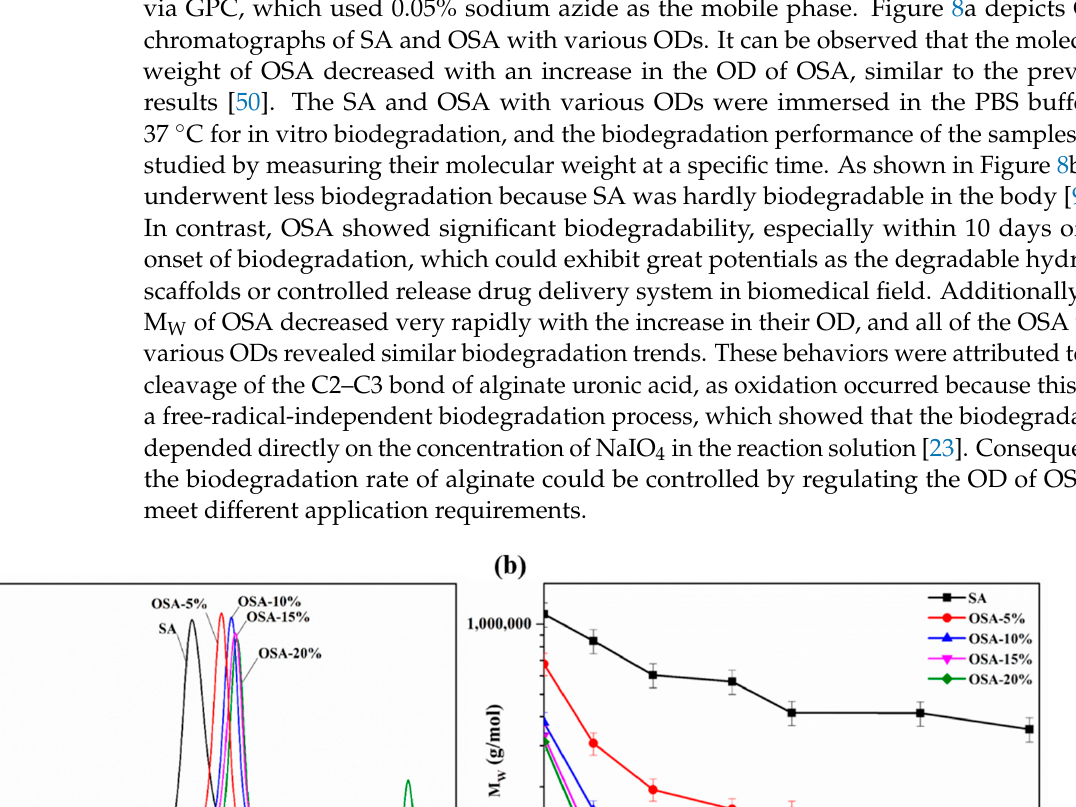
Figure 7. ( a ) TGA curves and ( b ) DTG curves of SA and OSA.